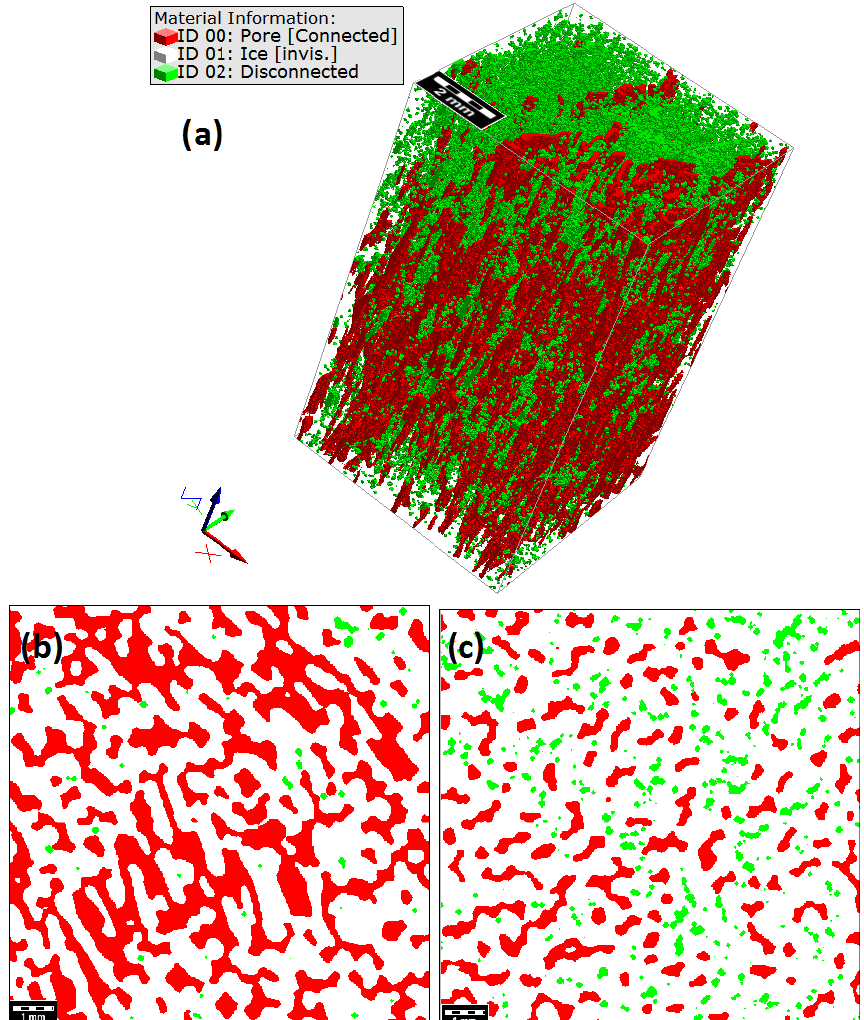
Figure 5. XRT micro-tomographic images illustrating the open (red) pores and closed (green) brine pores in young sea ice. (a) 3D image, ice being invisible; (b) horizontal section from the 3D image with open pores dominating, ice being white; (c) horizontal section from the 3D image with a similar fraction of open and closed pores. The 2D scale bar is 1mm; the side length is